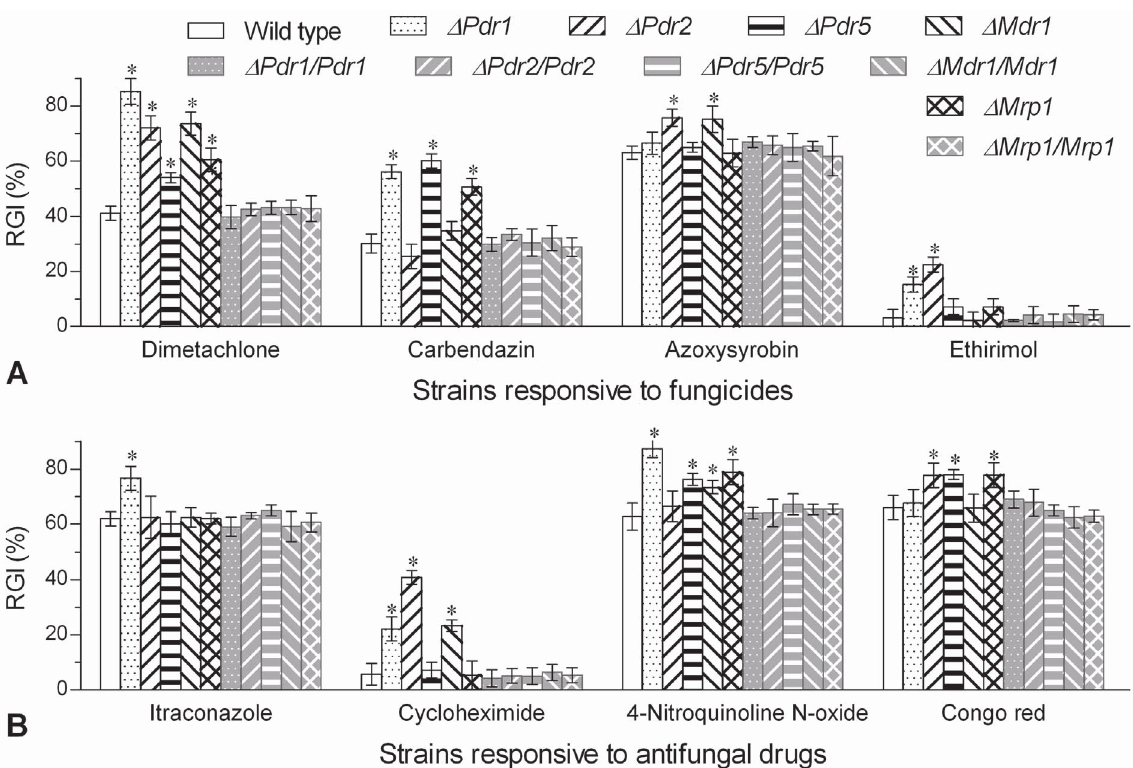
Figure 2. Changes in multidrug resistance of five single-gene disruption mutants of B.bassiana . (A) Relative growth inhibition (RGI) of fungal colonies after 6-day incubation at 25 u C on 1/4 SDAY supplemented with the fungicides dimetachlone (0.1 mg/ml), carbendazim (0.5 m g/ml), azoxysyrobin (0.1 mg/ml) and ethirimol (1 mg/ml) respectively. (B) RGI values of fungal colonies after 6-day incubation at 25 u C on 1/4 SDAY supplemented with the antifungal drugs itraconazole (5 m g/ml), cyclonheximide (20 m g/ml), 4-nitroquinoline-N-oxide (5 m g/ml) and Congo red (0.5 mg/ml) respectively. The bars of each group marked with asterisks differed significantly from those unmarked (Tukey’s HSD, P , 0.05). Error bars: SD of the mean from three repeated